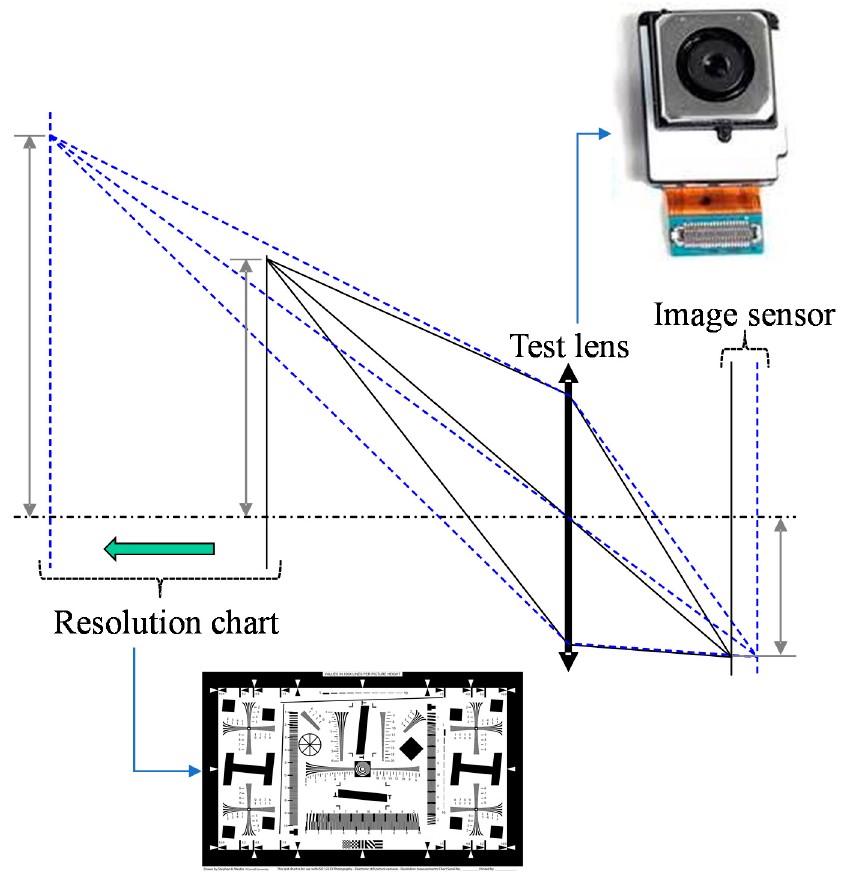
Figure 1. Test layout of the mobile phone camera optics.